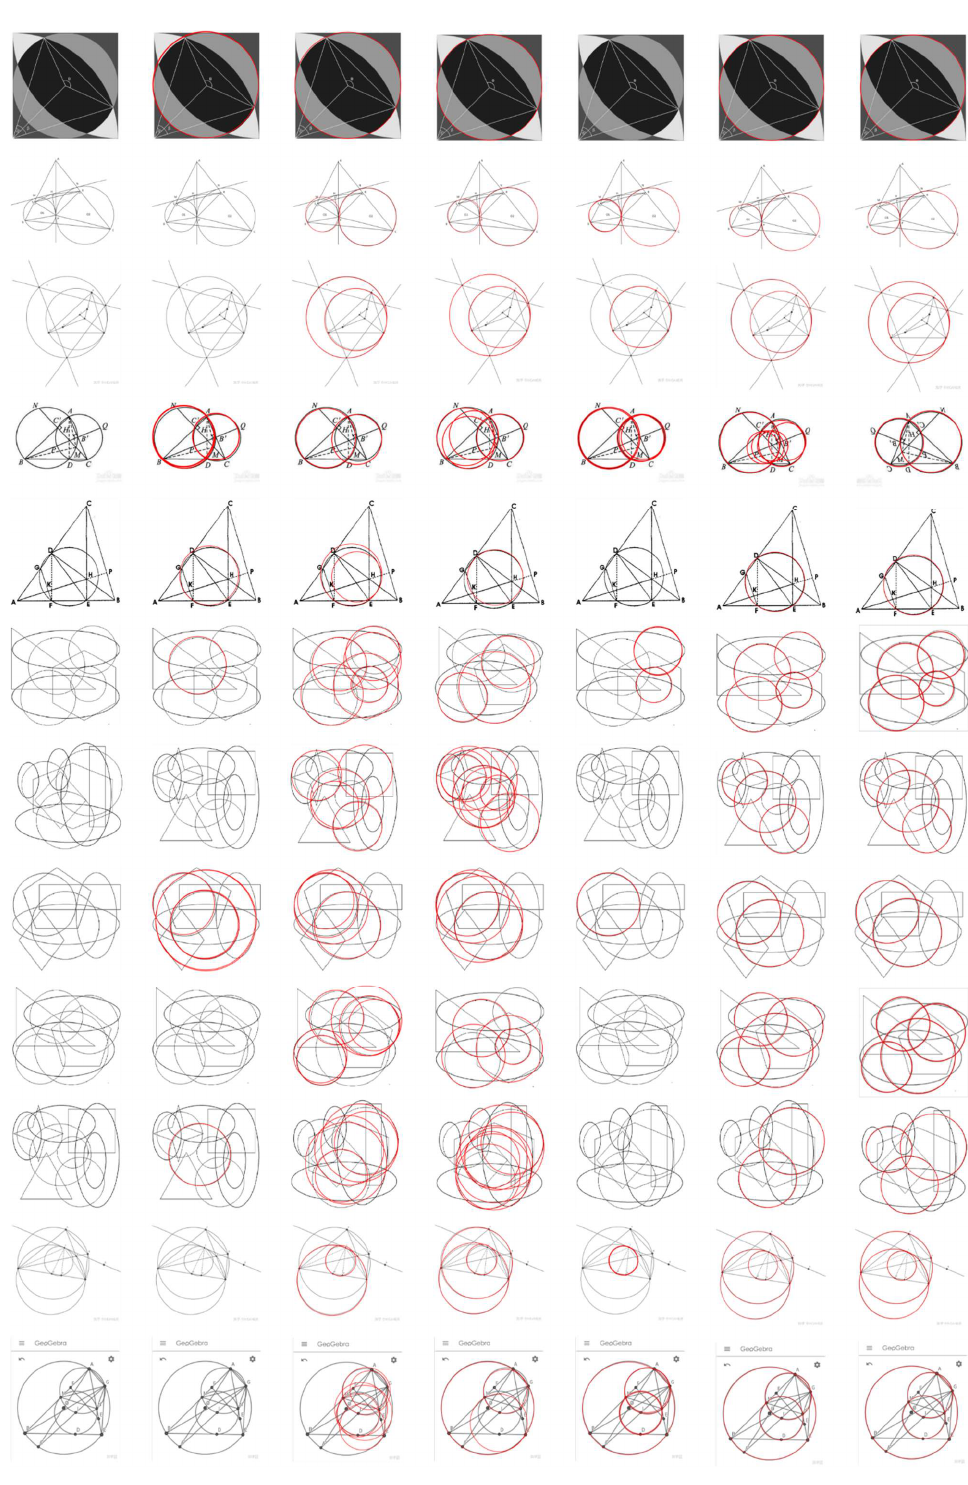
Figure 7. Circle detection results on the dataset Geometry. From the left to right columns: input image, RHT, RCD, CACD, Jiang, Wang and ours. As can be seen, the proposed method obtains better performance than